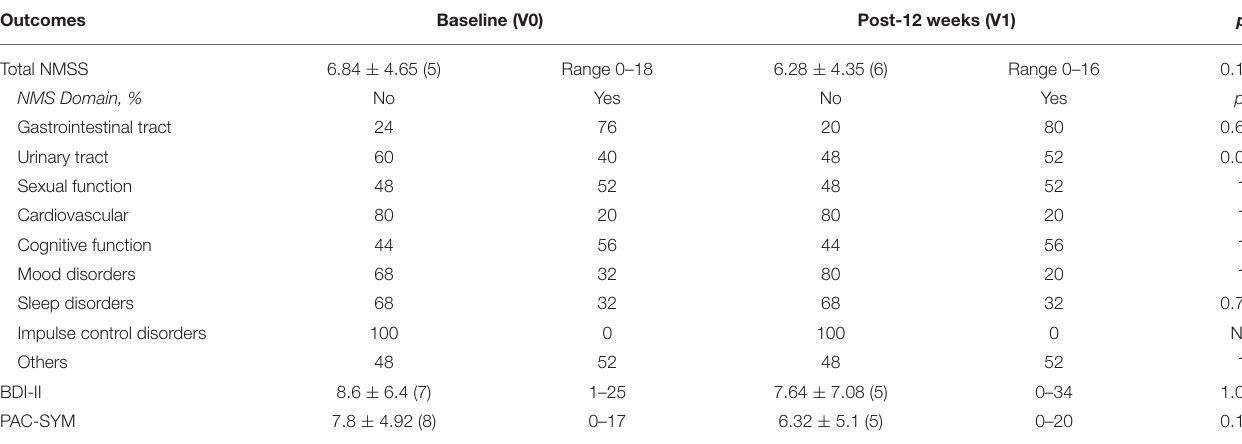
TABLE 5 | The non-motor symptoms of patients with PD at baseline and after 12 weeks of intervention. Outcomes